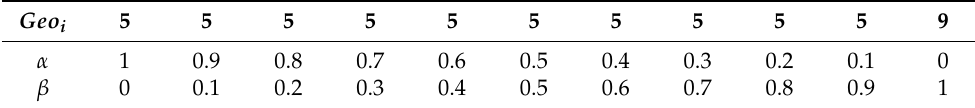
Table 11. Optimization outcomes varying